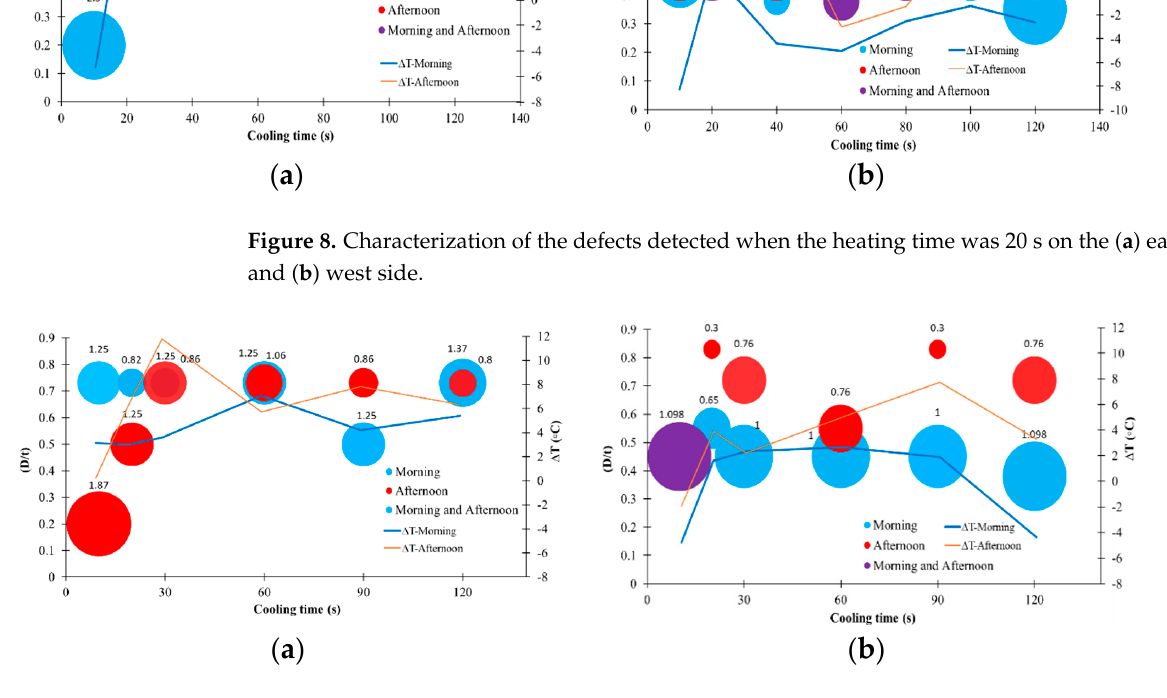
Figure 9. Characterization of the defects detected when the heating time was 30 s on the ( a ) east side and ( b ) west side.